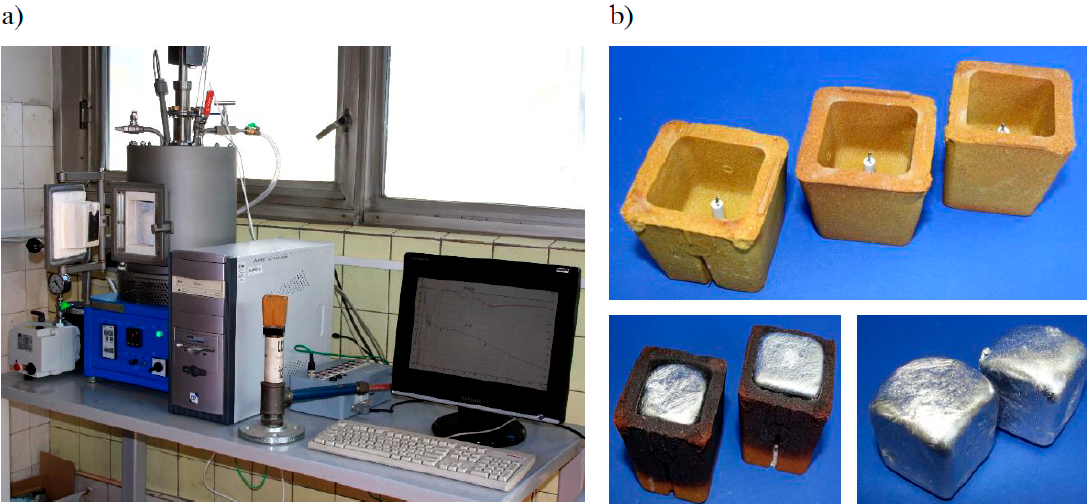
Figure 1. Thermal analysis by ATD (analysis thermal derivative) method (standard QC 4080): ( a ) test stand, ( b ) ATD sampler and castings.